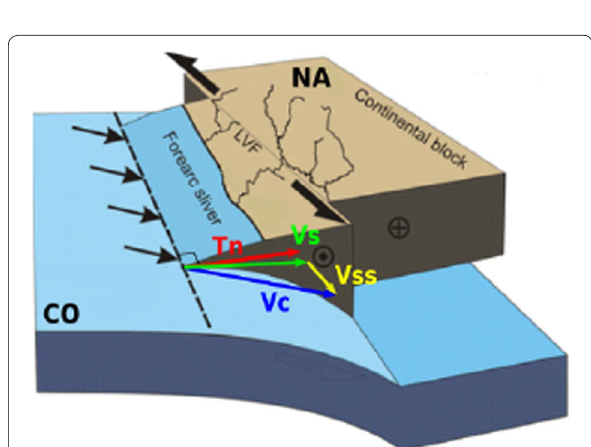
Fig. 4 Forearc sliver. Relative motion of the NA and CO tectonic plates is partially accommodated by slip on the subduction interface and slip on the La Venta-Chacalapa (LVF) system of trench-parallel crustal strike-slip faults. V c —velocity vector of the subducting plate relative to the fixed upper plate; T n —trench normal; V s —surface projection of the coseismic slip vector for subduction thrust earthquakes; V ss —forearc sliver velocity. Black arrows indicate direction of convergence; black half-arrows show sinistral motion at the LVF [Modified from Gaidzik et al.